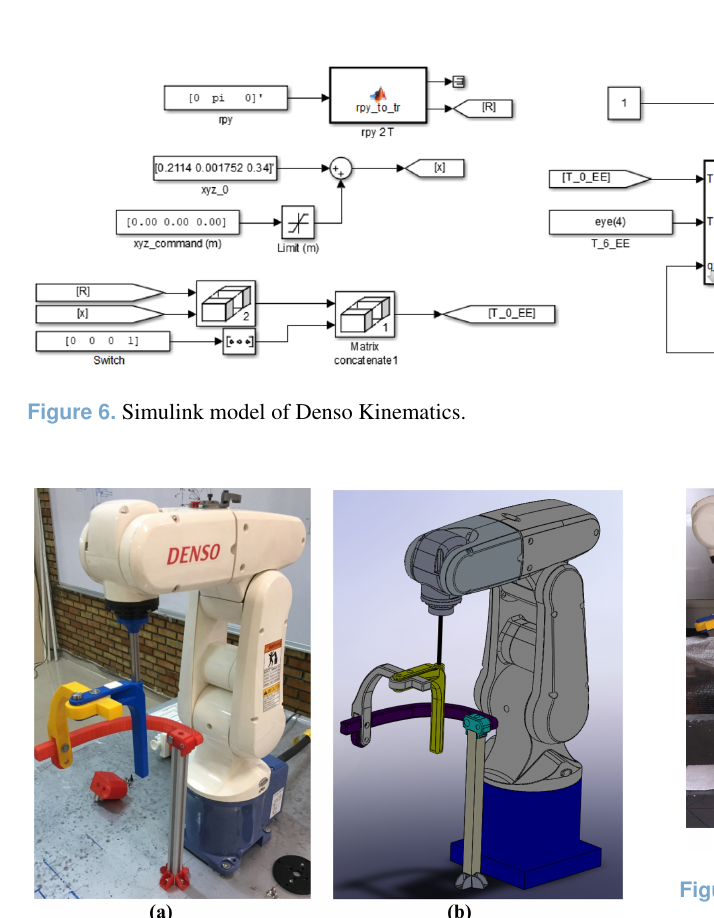
joint stationary, the other 3 DOF of the Robot are for gener- ating orientation change of the wrist joint for FE, PS and AA motions. The overall system is shown in Fig. 7a, b.